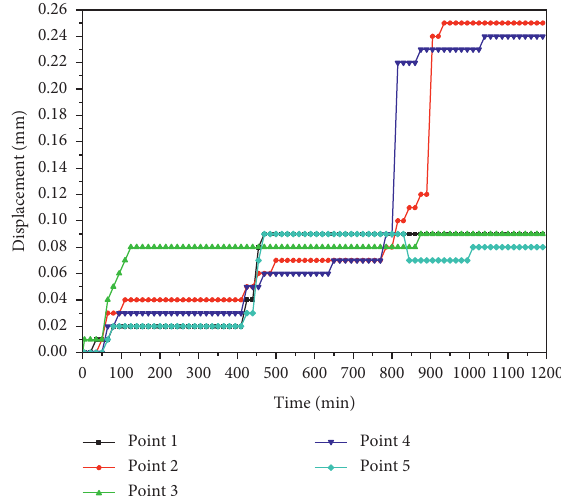
Figure 5: Displacement duration curve of L3 section in excavation scheme